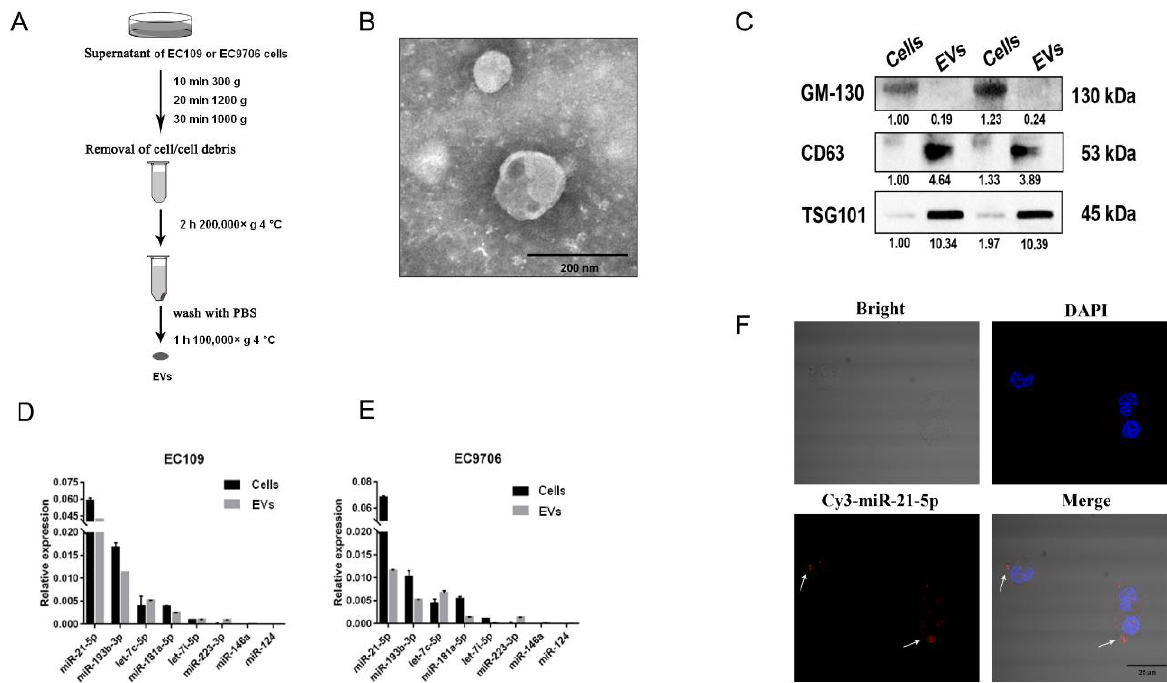
Figure 2. EVs-miR-21-5p secreted by ESCC cells were taken up by PMA-treated macrophages. ( A ) Workflow describing isolation of EVs from EC109 supernatants. ( B ) Morphology of EVs under a transmission electron microscope (scale bar, 200 nm). ( C ) Western blot analysis of EVs markers (CD63 and TSG-101) and a protein, GM-130, that is not found in EVs. Macrophage polarization-related miRNAs were detected by q-RT-PCR in EC109 ( D ) and EC9706 ( E ) cells. ( F ) Confocal microscopy was used to observe the uptake of Cy-3 labeled EVs-miR-21-5p by PMA-treated macrophages. Blue: DAPI staining; red: Cy3-miR-21-5p; scale bar: 25 µ m. The uncropped Western Blot images can be found in Supplementary Materials.